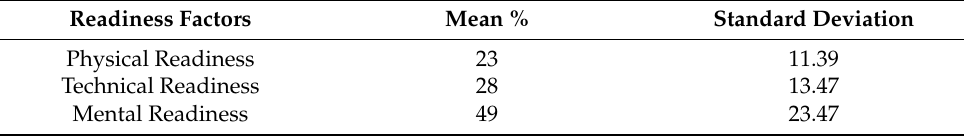
Table 1. Importance for Readiness in